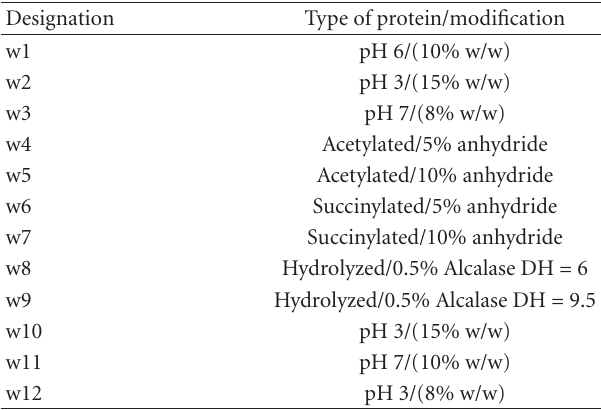
Table 1: Di ff erent types/modifications of whey protein